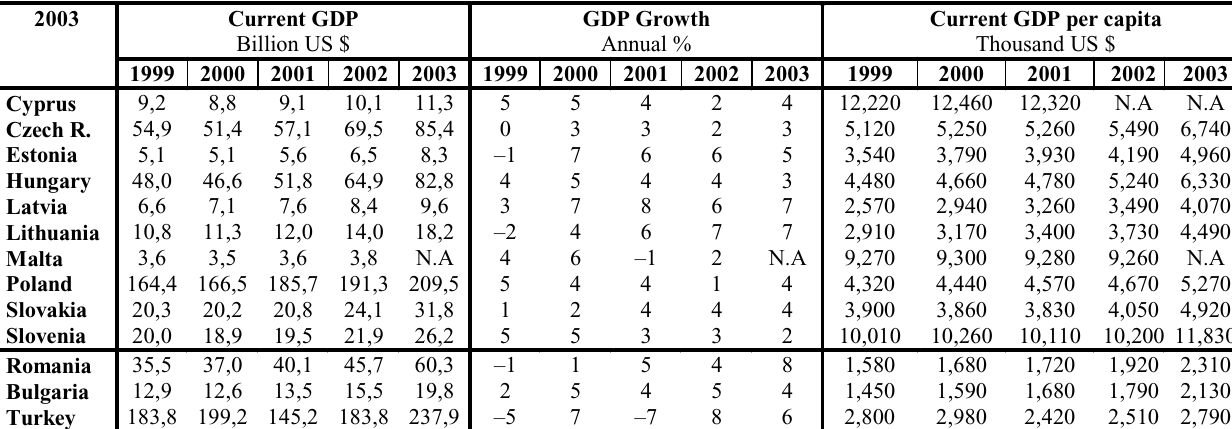
Table 8. Comparison of Turkey with Romania, Bulgaria and the 10 new members of the EU in terms of macroeconomic